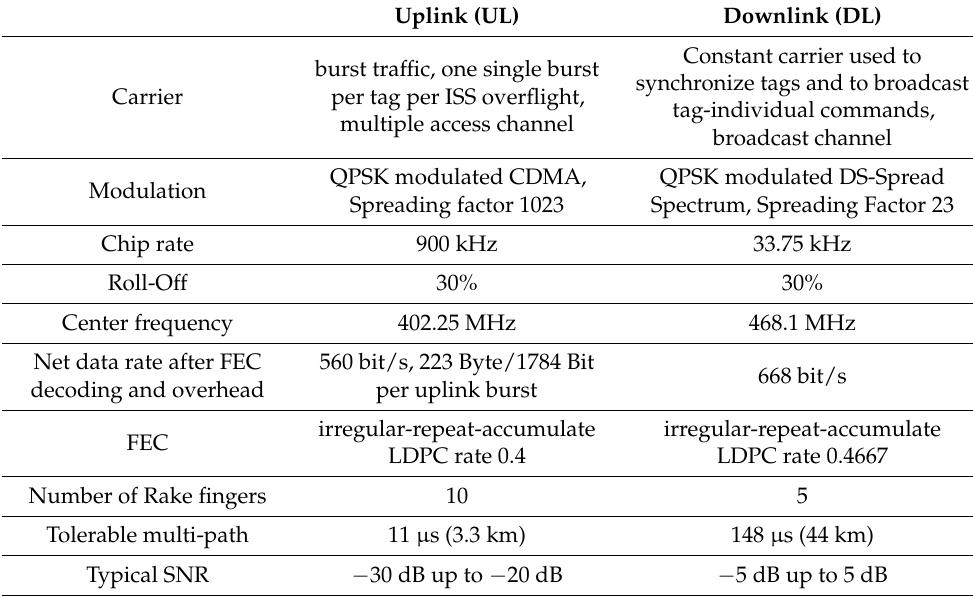
Table 1. ICARUS Uplink and Downlink System